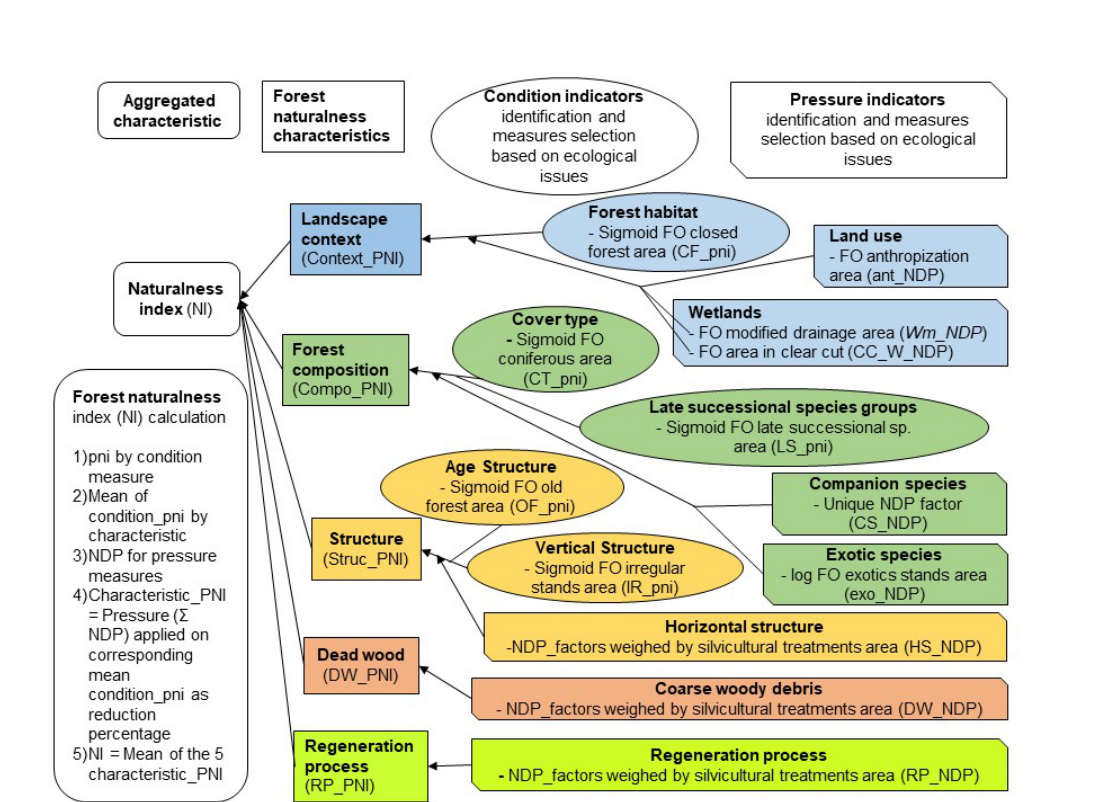
Figure 2. A naturalness evaluation conceptual model for the black spruce and feathermoss boreal forest. PNI: Partial naturalness index for naturalness characteristic; pni: partial naturalness index for condition indicator; NDP: Naturalness degradation potential; FO: Function